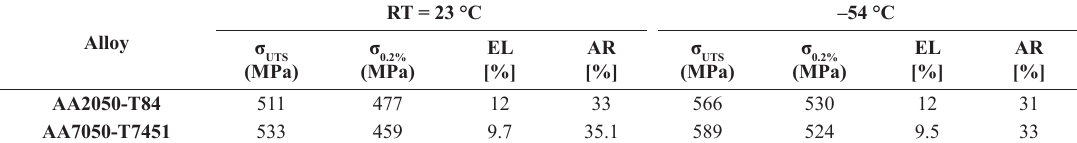
Table 3. Tensile properties.